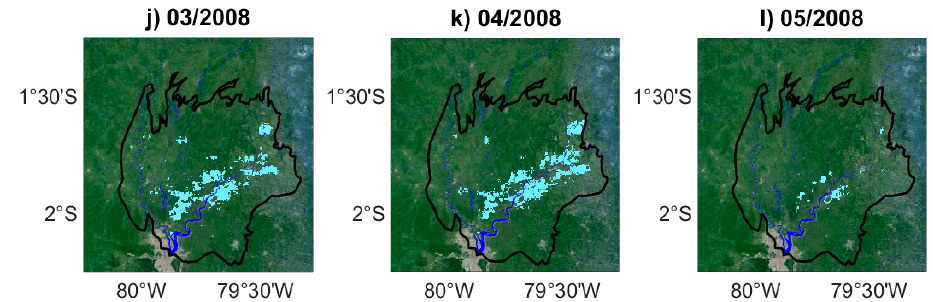
Figure 11. Monthly maps of inundation for normalized anomalies of backscattering coefficients lower than − 2.30 (light blue) in the Guayas floodplain (black line) during the wet seasons of 2005 and 2006 ( a – f ) from December 2006 to May 2007; and ( g – l ) from December 2007 to May 2008. Background image is from Google Maps. Permanent water bodies appear in blue.